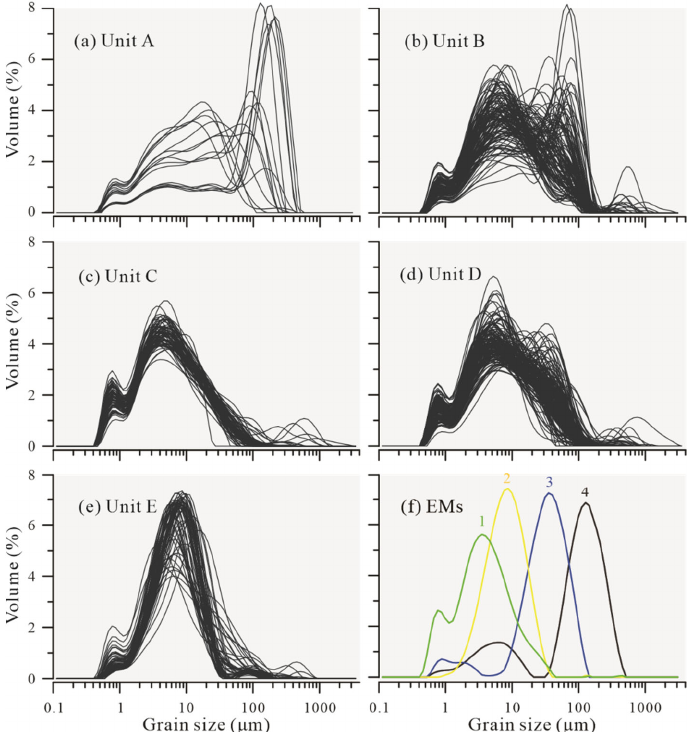
Figure 4. Frequency distribution curves of different units ( a – e ) and four EM curves ( f ) in core AGL ‐